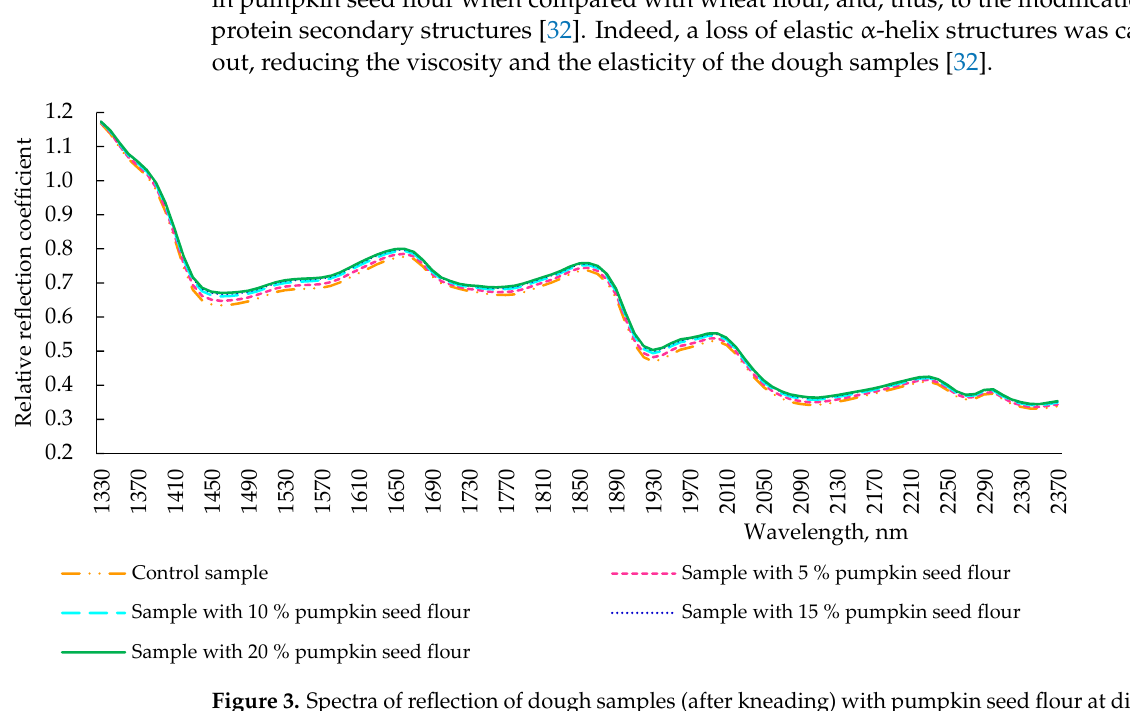
Figure 3. Spectra of reflection of dough samples (after kneading) with pumpkin seed flour at different concentrations (0, 5, 10, 15, and 20 %).